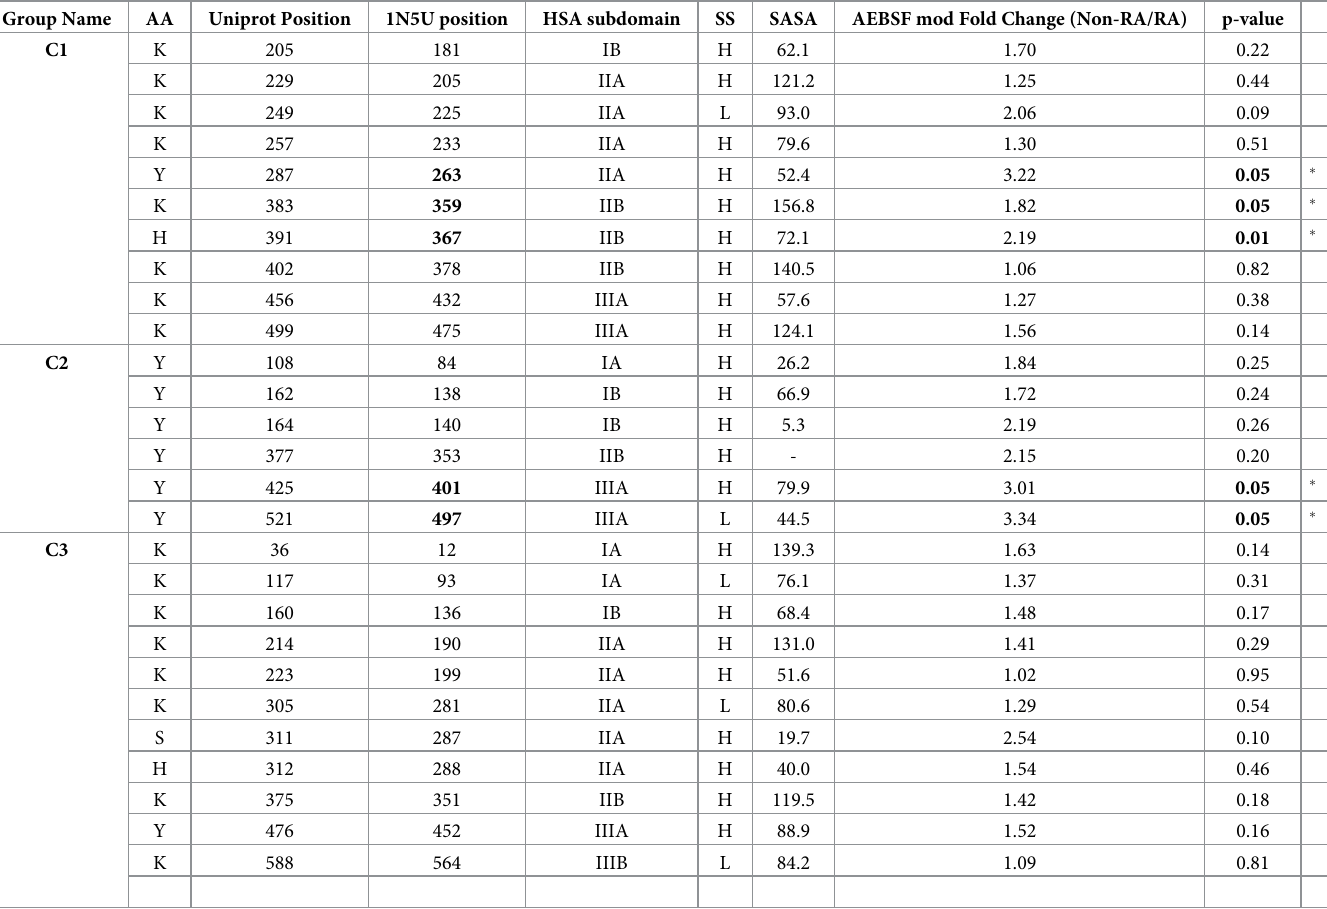
Table 1. Each of the AAmod sites for groups C1, C2, and C3. Group